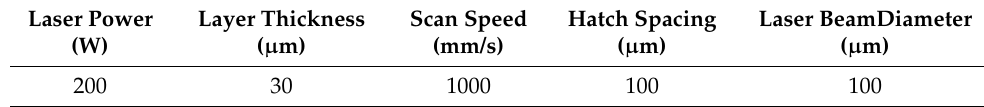
Table 2. Processing parameters used in the PLBF process.